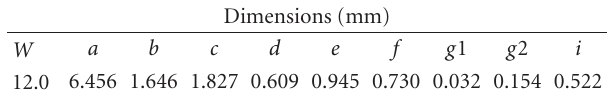
Figure 2: Simulated reflection phase of the AMC surface for di ff erent incident field ( E inc ) polarization angles = 0 ◦ , 15 ◦ , 30 ◦ , 45 ◦ , 60 ◦ , and 90 ◦ . Table 1: Unit-cell dimensions.